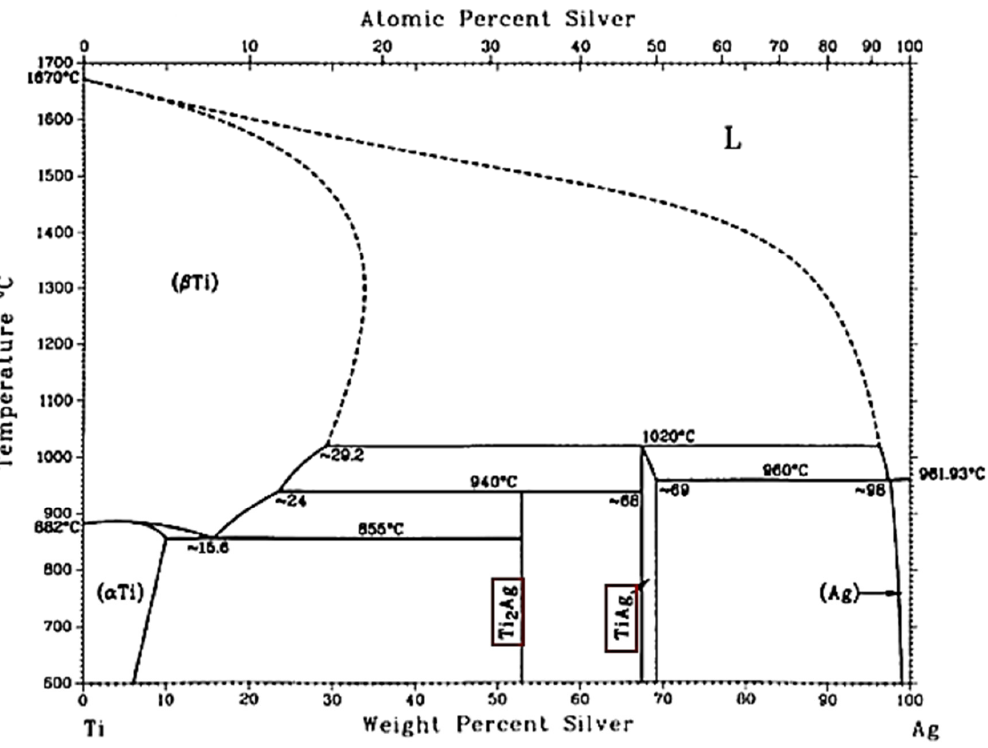
Figure 14. Equilibrium binary diagram of Ti-Ag [30].